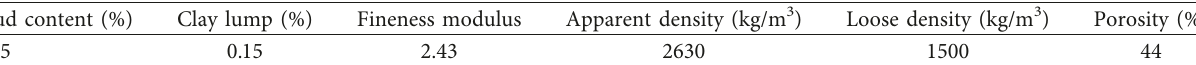
Table 2: Main properties of sand.